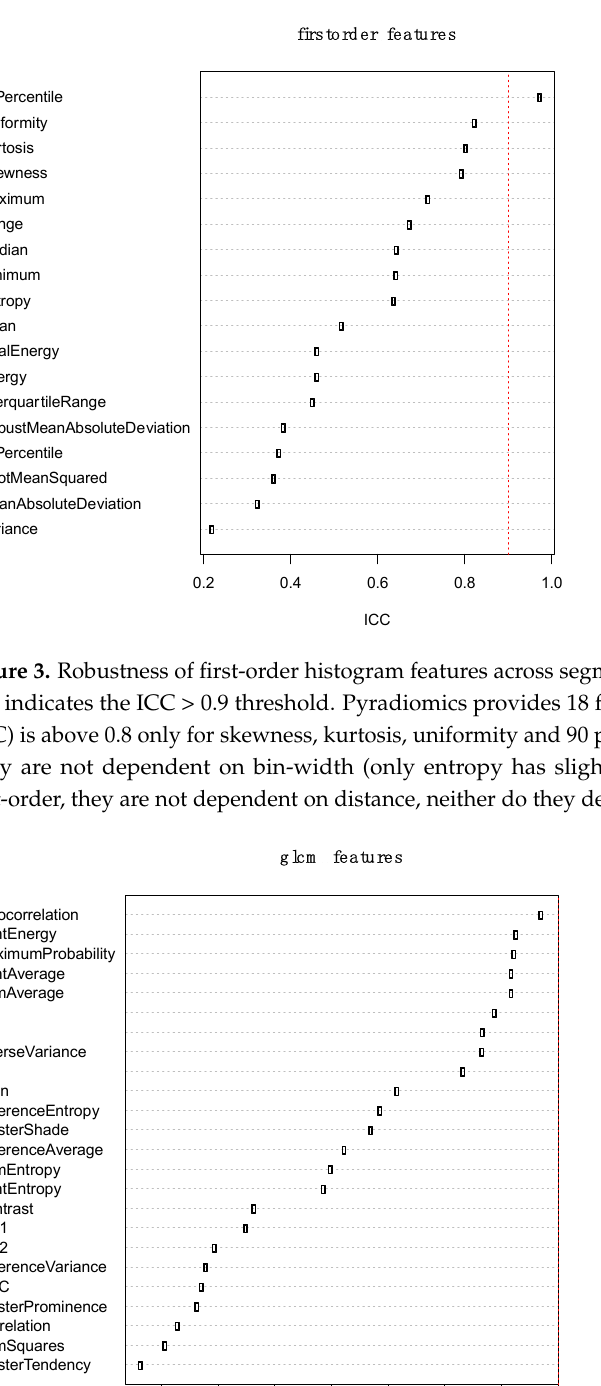
contours. They do not depend on bin-width, distance, resolution or interpolator. With the exception of Flatness, the other features have a robustness greater than 0.95.